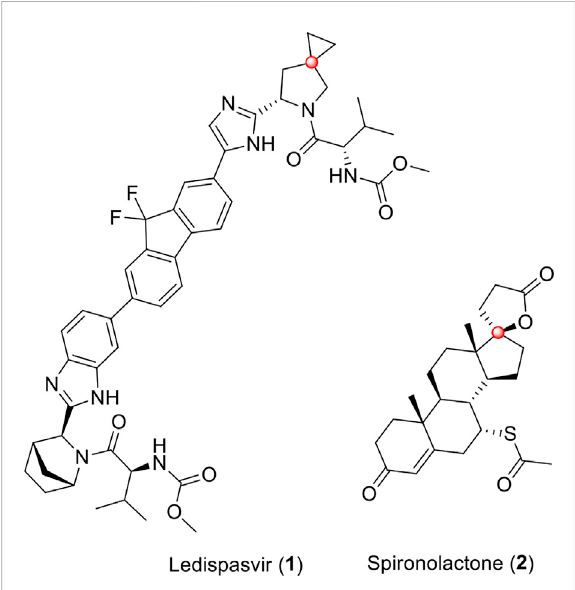
FIGURE 1 Ledipasvir ( 1 ) and spironolactone ( 2 ) are the two drugs in clinical use, which contain a spirocyclic scaffold in their molecular structures. Spiro carbons are highlighted in